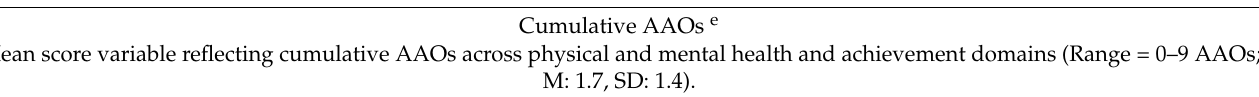
Table 1. Cont. Adult Adverse Outcomes (AAOs)